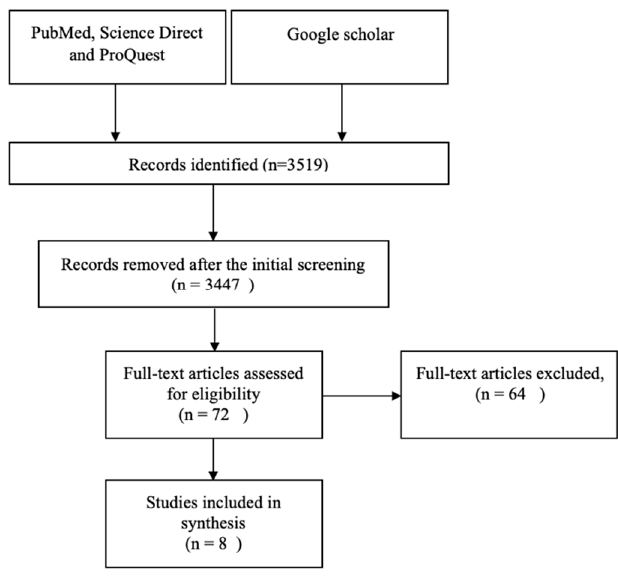
Figure 1. Flow diagram for literature search and screening.